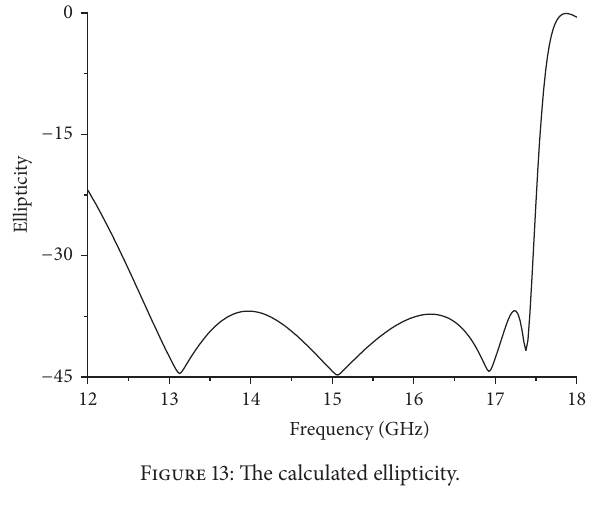
Figure 13: The calculated ellipticity.